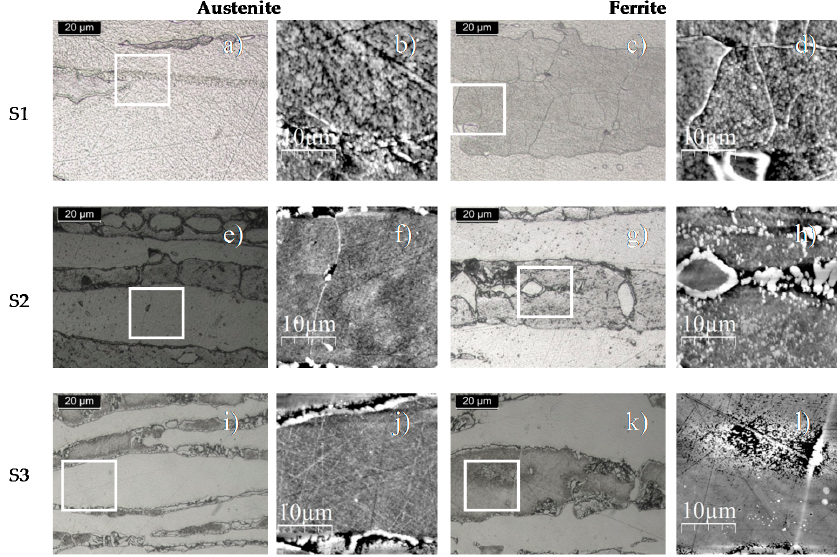
Figure 6. Selected zones of austenite and ferrite phases for nanohardness measurements: S1 ( a – d ); S2 ( e – h ) and S3 ( i – l ), respectively. White rectangles in the optical images (left ones) mark the zone where AFM images have been obtained (right ones).